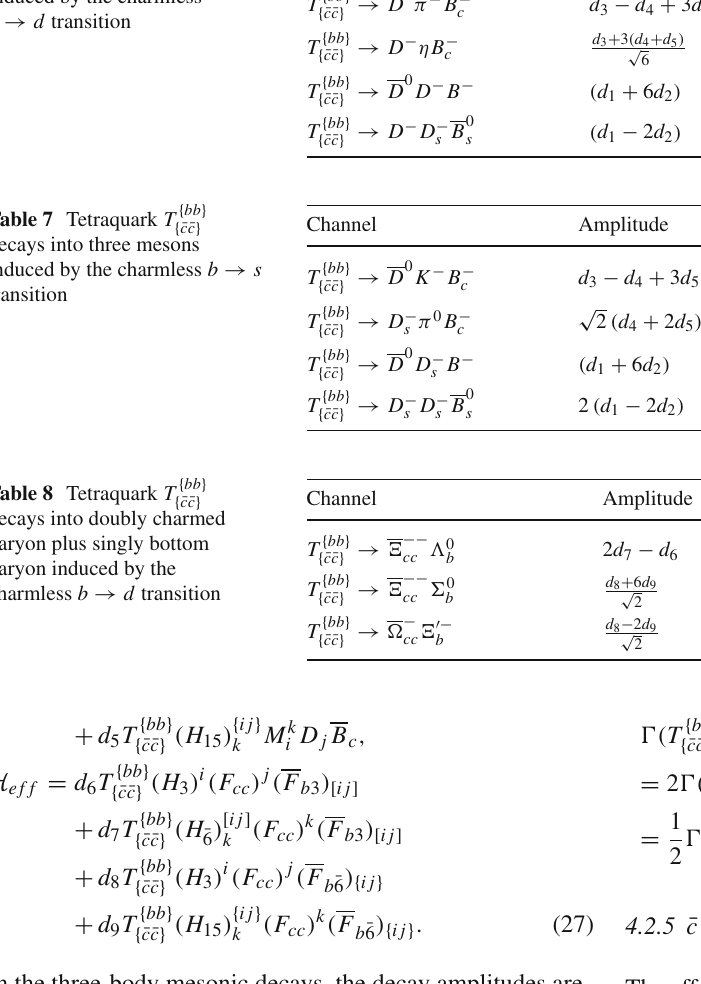
{ bb } Table 6 Tetraquark T Channel Amplitude Channel {¯ c ¯ c } decays into three mesons induced by the charmless b → d transition